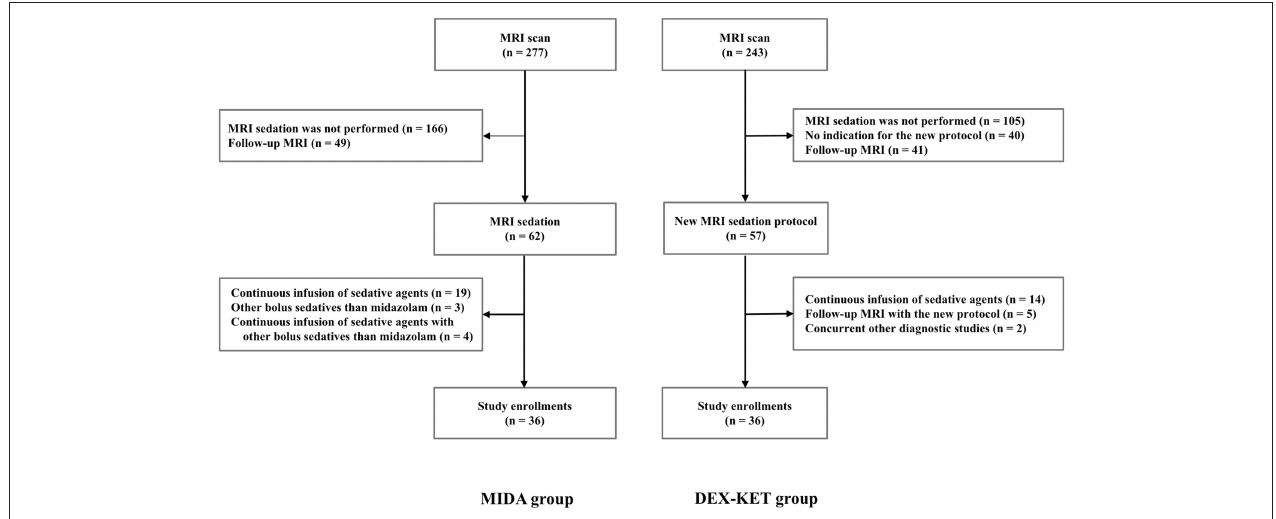
FIGURE 1 | Flowchart of the patient selection